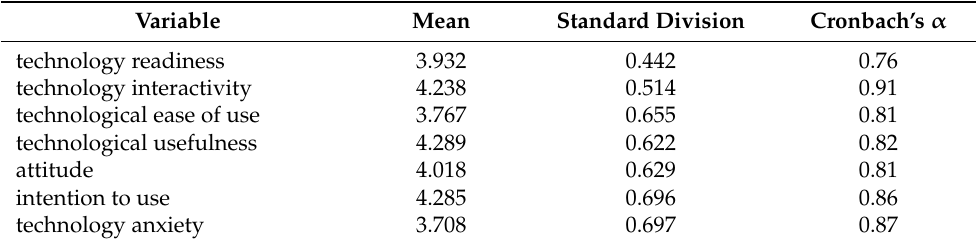
Table 3. Variable reliability